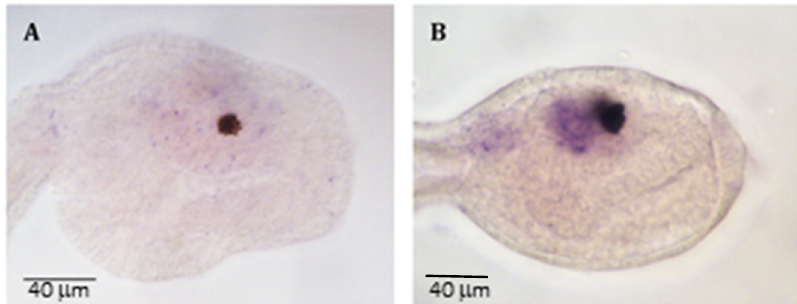
Figure 3. C. intestinalis miR-7 expression at the late tailbud stage in embryos injected with ( A ) PNA- a7 and ( B ) PNA-sc7. Scale bar = 40 µm